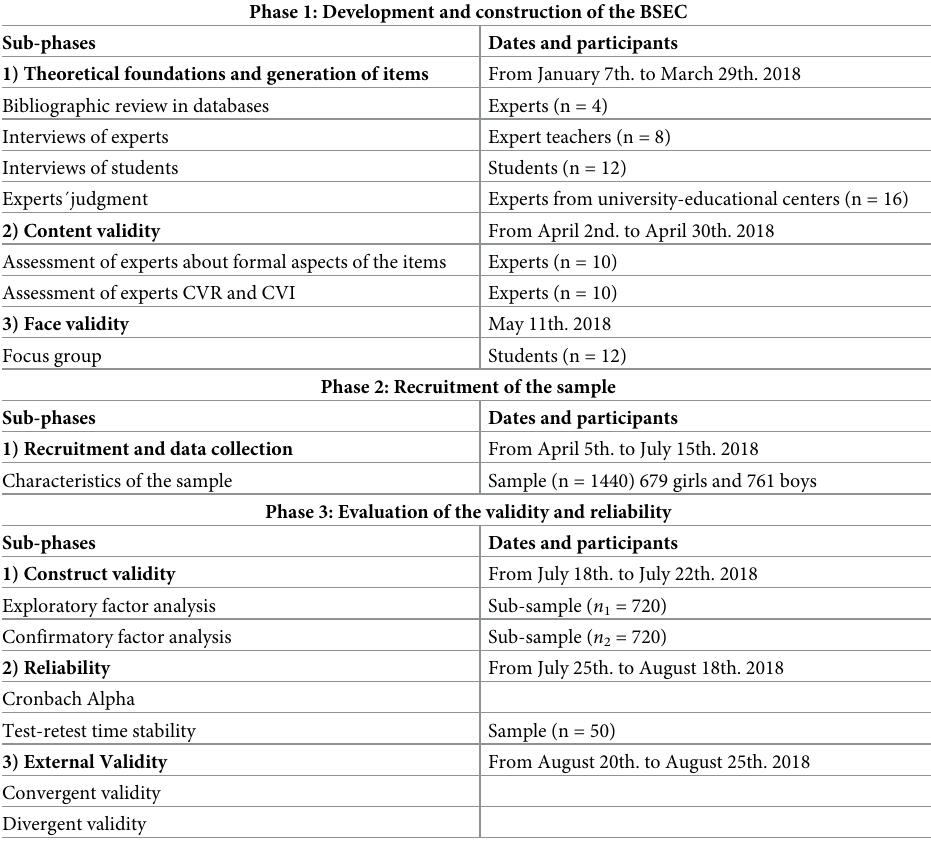
Table 1. Construction process and chronological axis of the research